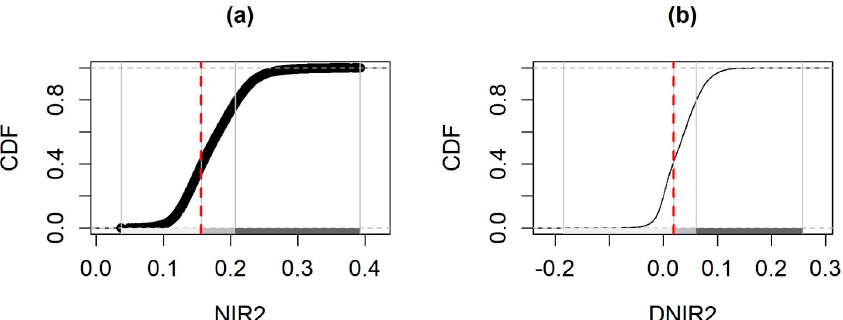
Figure 3. ( a ) Cumulative density function (CDF) and Jenks natural breaks for post-fire near-infrared reflectance (NIR) reflectance values (T2); ( b ) Cumulative density function (CDF) and Jenks natural breaks for pre-fire minus post-fire NIR reflectance differences. Red dashed lines represent thresholds for sample selection. Black arrows show values admitted for sample selection.